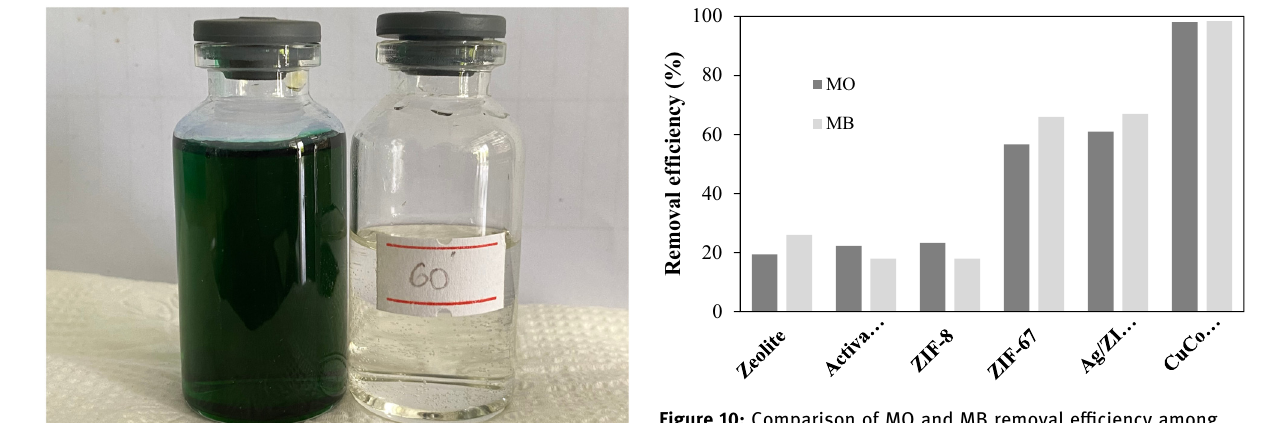
( Figure 9 ) . Five types of heterogeneous catalysts, including zeolite, activated carbon, ZIF - 8, ZIF - 67, and Ag/ZIF - 67, were also used to compare with CuCo - ZIFs under the identical conditions for each dye ( Figure 10 ) . The optimum condi - tions for MO and MB removal included catalyst dosage, O concentration, initial dye concentration, and reaction H 2 2 time from previous experiments were used. For MO, they were 100 mg · L − 1 catalyst, 0.2 mol · L − 1 H O , 50 mg MO · L − 1 , 2 2 60 min, and a pH value of 7.0 at ambient temperature, respectively. The optimal conditions of MB removal were O , 40 mg MB · L − 1 , reaction 50 mg · L − 1 catalyst, 0.1 mol · L − 1 H 2 2